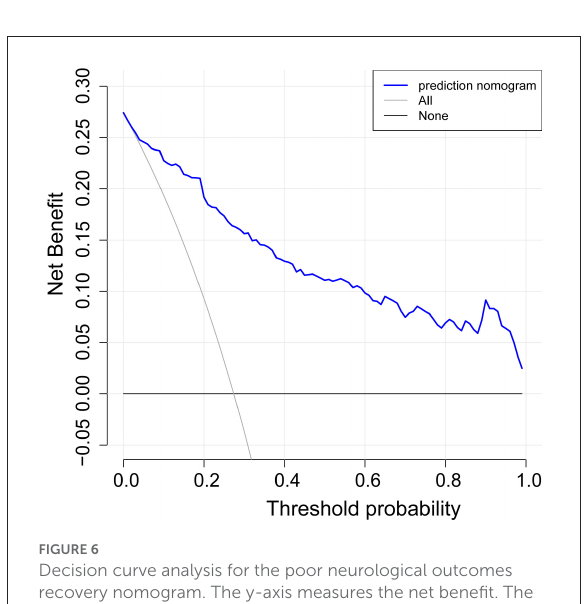
FIGURE6 Decision curve analysis for the poor neurological outcomes recovery nomogram. The y-axis measures the net benefit. The blue line represents the poor neurological outcomes recovery risk nomogram. The light gray line represents the assumption that all patients suffer from poor neurological outcomes recovery. The black solid line represents the assumption that no patients suffer from poor neurological outcomes